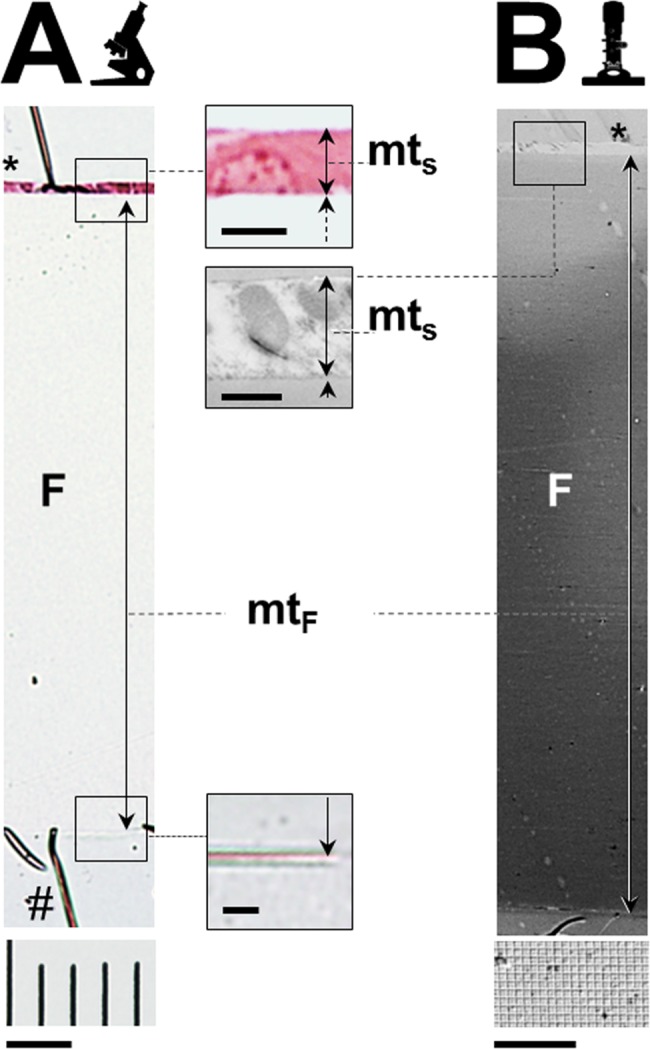
Light- and electron-microscopic images of sections of re-embedded GMA/MMA sections mounted on calibration foils.Compare to Fig 3. The thicknesses (mtF) of the calibration foils (F) and the thicknesses (mtS) of the re-embedded sections (*) are indicated. (A) Light microscopic image of a re-embedded, 3 μm thick GMA/MMA section of mouse kidney tissue mounted on a calibration foil (ACLAR®, Plano, Germany) of 198 μm (true) thickness. #: Tension fold at the interface of the calibration foil and the surrounding Epon resin. GMA/MMA section, HE-staining, 200 x magnification. For calibration, the image of an object micrometer (distance between scale lines: 10 μm) photographed under identical conditions is displayed (bar = 20 μm). The insets to A show detail enlargements of the profile of the orthogonally re-embedded tissue section (top inset, bar = 5 μm) and the lower surface of the calibration foil (bottom inset, bar = 5 μm). (B) Transmission electron microscopic image of a re-embedded, 1 μm thick GMA/MMA section of mouse kidney tissue mounted on a calibration foil (LIST-MAGETIK®, Germany) of 49 μm (true) thickness. 1000 x magnification. For calibration, the image of a standard cross-grating calibration grid (width of squares: 0.463 μm) photographed under identical conditions is displayed (bar = 10 squares). The inset to B shows a detail enlargement of the profile of the orthogonally re-embedded tissue section (10,000 x magnification, bar = 0.463 μm).